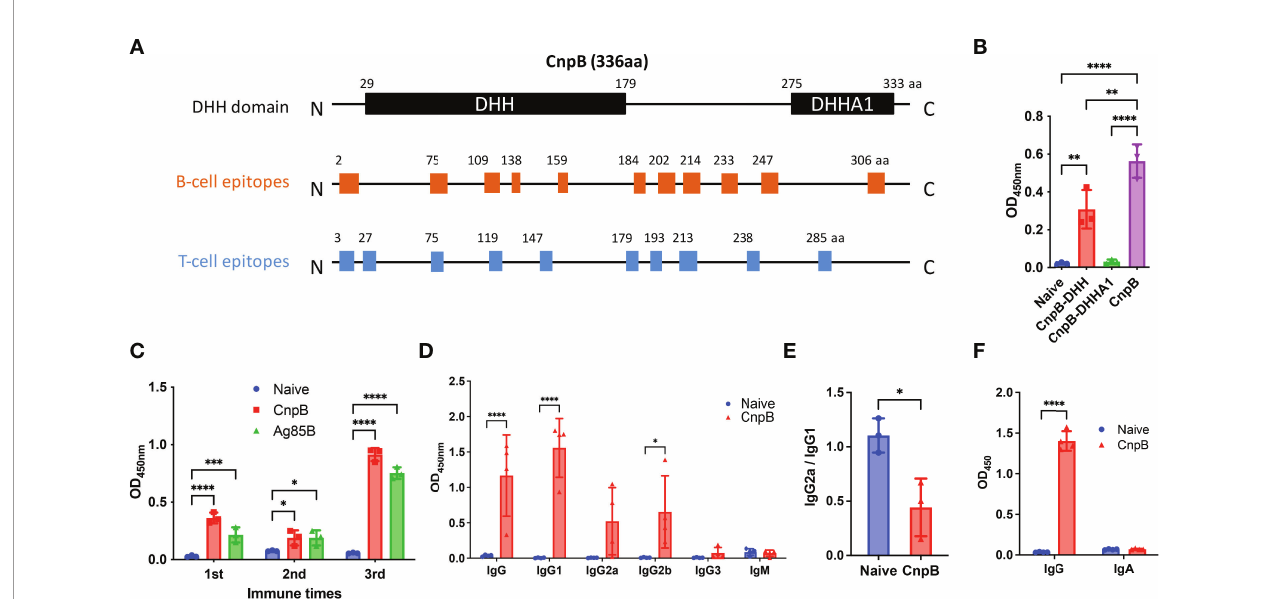
FIGURE 2 | The humoral immune response of CnpB immunization in mice. (A) Prediction of B-cell and T-cell epitopes on CnpB. (B) Sera antibodies of DHH, DHHA1 truncated proteins, and CnpB full-length protein were detected by ELISA in CnpB-immunized mice ( n =3). (C) Antigen-speci fi c antibodies against CnpB or Ag85B in sera from CnpB or Ag85B immunized mice (50 m g of CnpB, DHH (1-179aa), DHHA1 (180-336aa) or Ag85B protein were inoculated subcutaneously with incomplete Freund ’ s adjuvant for three times at 2-week intervals) detected by ELISA ( n =3). (D) Antibody subclasses against CnpB in sera of CnpB immunized mice detected by ELISA ( n =4). (E) IgG2a/IgG1 ratio of sera antibody subclasses in CnpB immunized mice ( n =3). (F) The levels of IgG and sIgA in bronchoalveolar lavage fl uid of CnpB immunized mice ( n =4). The results are expressed as mean ± SD. * P < 0.05, ** P < 0.01, *** P < 0.001, **** P <